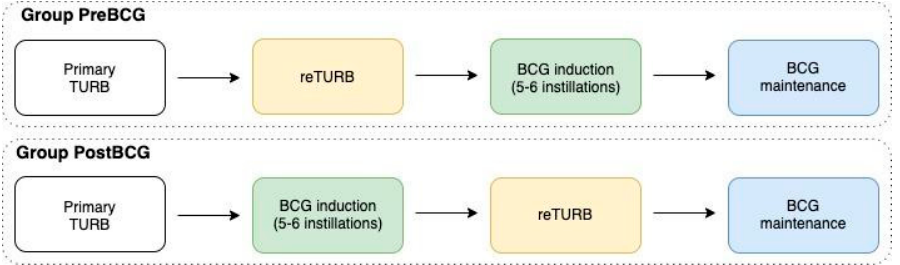
Figure 1. Therapeutic sequence after primary TURB (transurethral resection of bladder tumour).